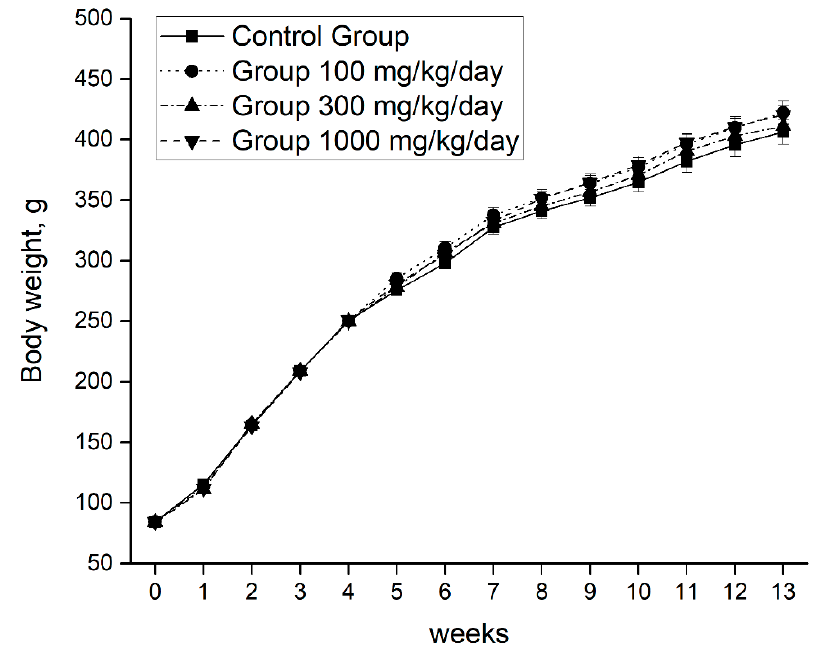
Figure 2. Body weight evolution during the 90 days of intervention. Data are means ± SEM. One-way ANOVA test and Bonferroni post hoc were used to compare results between groups at each time point. P < 0.05 was considered significant . One-way analysis of variance, ANOVA .